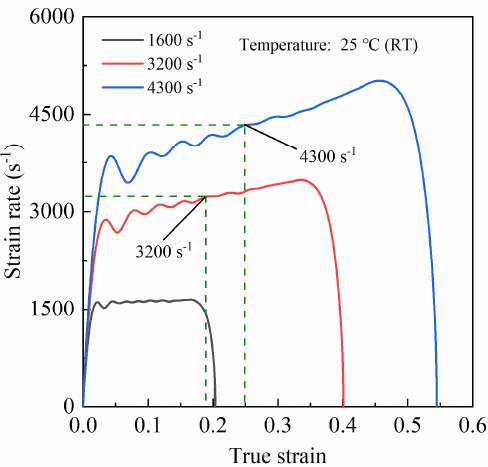
Figure 6. Strain rate history curves under various impact speeds.